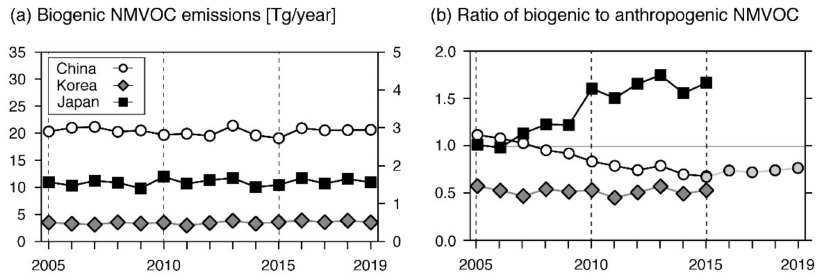
Figure 8. ( a ) Annual amounts of NMVOC biogenic emissions over China (white circles, left axis), the Republic of Korea (gray diamonds, right axis), and Japan (black squares, right axis) during 2005–2019. ( b ) The ratio of biogenic to anthropogenic NMVOC emissions over China (white circles), the Republic of Korea (gray diamonds), and Japan (black squares). The values are calculated based on REAS during 2005–2015, and the values over China during 2015–2019 are also calculated based on MEIC (light-gray circles; see also Figure